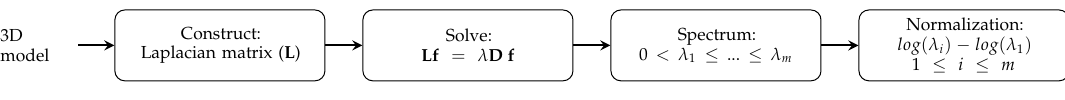
Figure 1. The block diagram of the proposed Laplacian Eigenmaps based scale-invariant (LESI) global shape